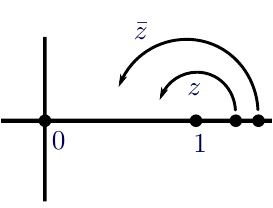
Figure 6 . Rotation of z, ¯ z counterclockwise from z, ¯ z > 1